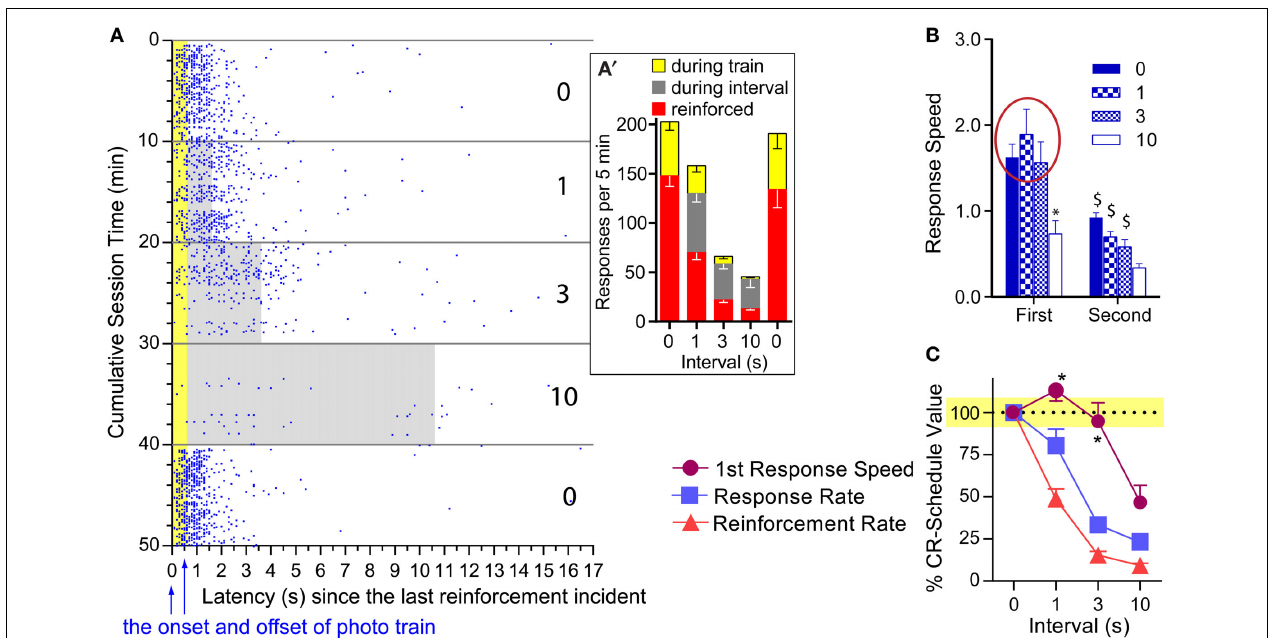
FIGURE 6 | Effects of pulse and interval on the first response after reinforcement. (A) Lever-press incidents with the 16-pulse train are plotted in relation to the last reinforcement incident and train duration. When presses shown in blue dots were emitted during the train duration (shown in yellow area) or during inter-reinforcement interval (gray area), they were not reinforced. The number on the right indicates inter-reinforcement intervals for the 10-min periods. (A’) Mean presses